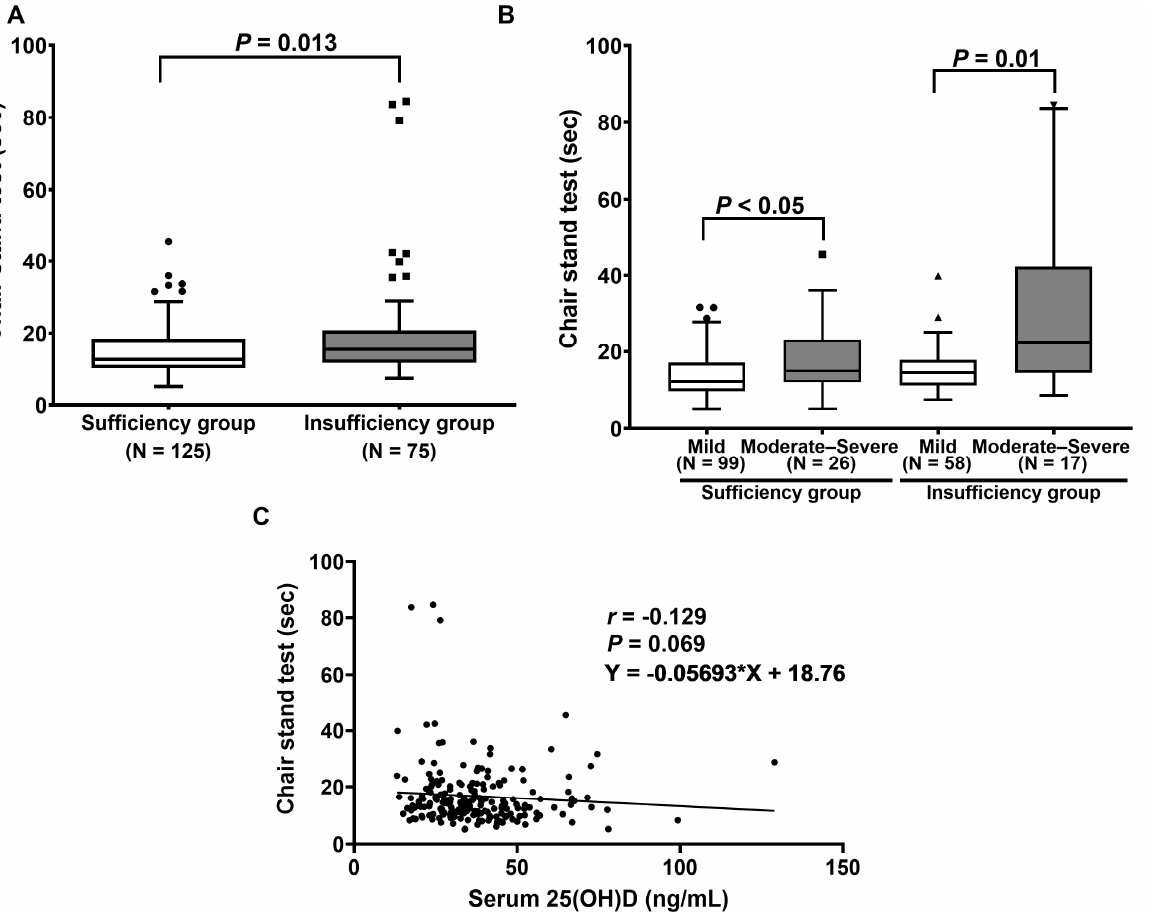
Figure 3. Determination of chair stand test: ( A ) Comparison of chair stand test between patients with vitamin D sufficiency and insufficiency. p -value was calculated with the Mann–Whitney U test. ( B ) Comparison of chair stand test between patients, classified by ODI score. p -value was examined using Friedman’s two-way ANOVA test. ( C ) Correlation between serum 25(OH)D and the time in chair stand test.